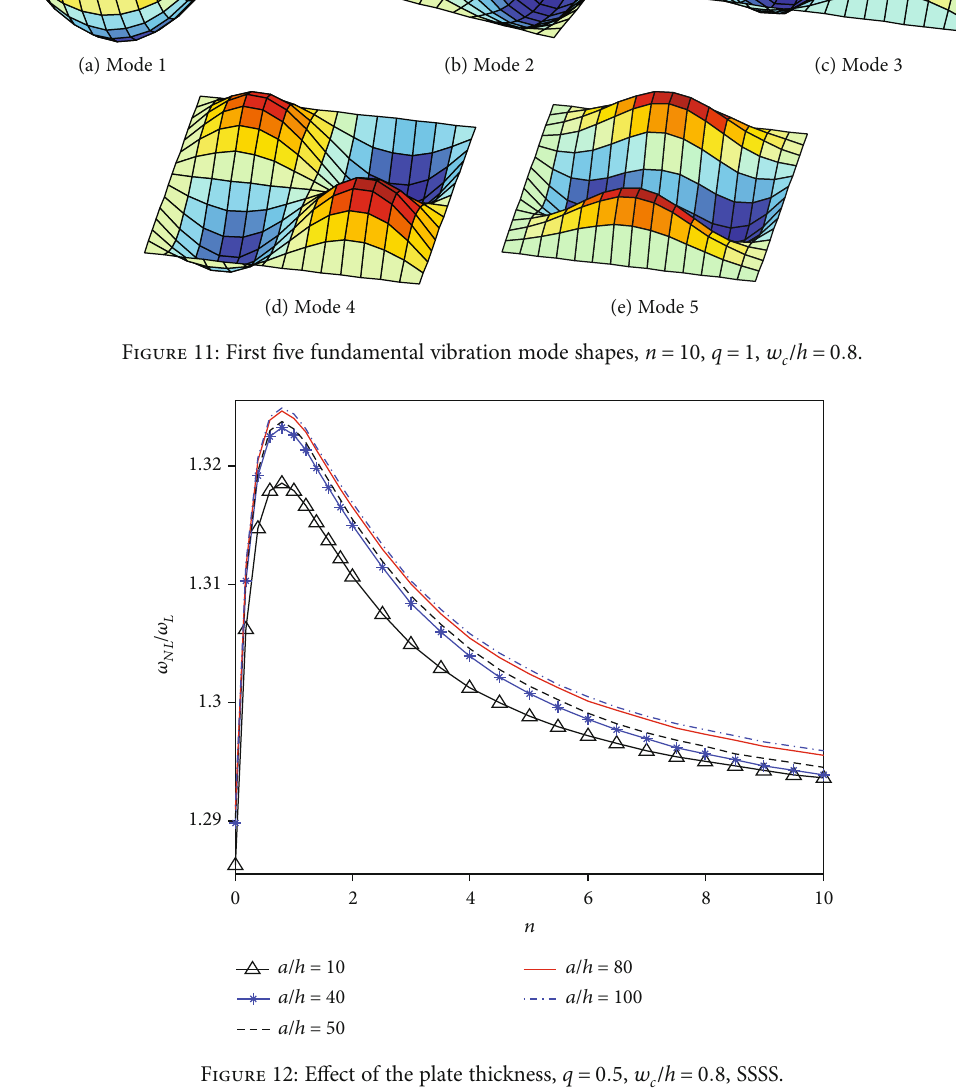
Figure 12: E ff ect of the plate thickness, q = 0 : 5 , w